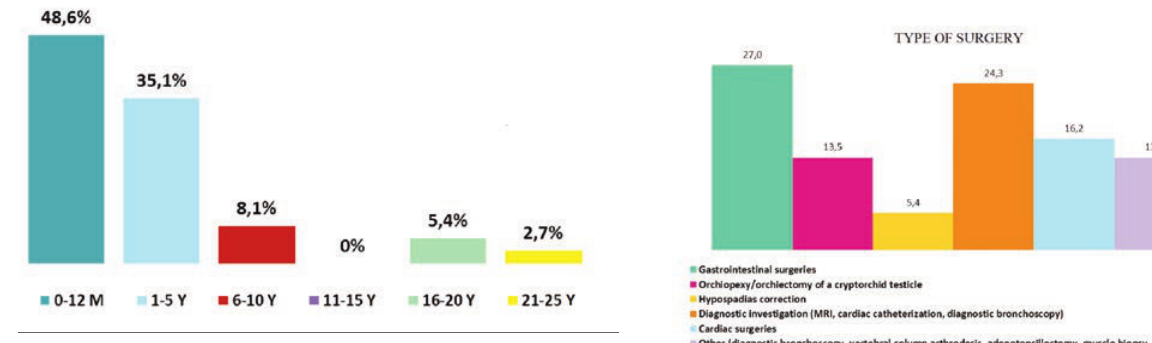
Figure 1. The age of patients as a percentage. At the time of gen- eral anesthesia, the age of patients ranged from month to 21 years.